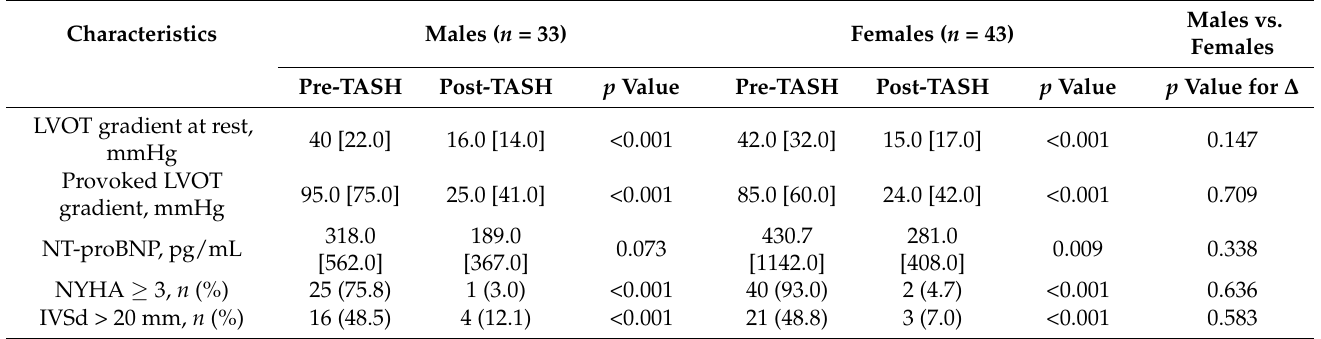
Table 3. Short-term outcomes after TASH (initial assessment and first clinical follow-up at 4 [8.0]